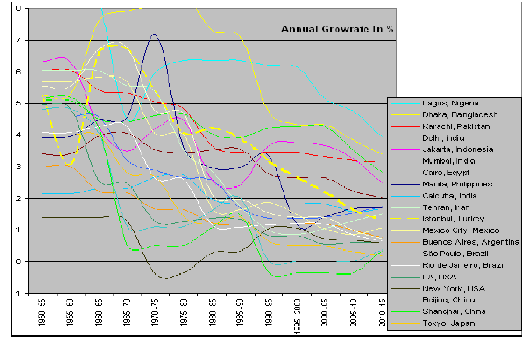
Figure 19: The population growth rate of the biggest and strongest growing agglomerations. (Data from UN 2004 in: UN - World Urbanization Prospects)